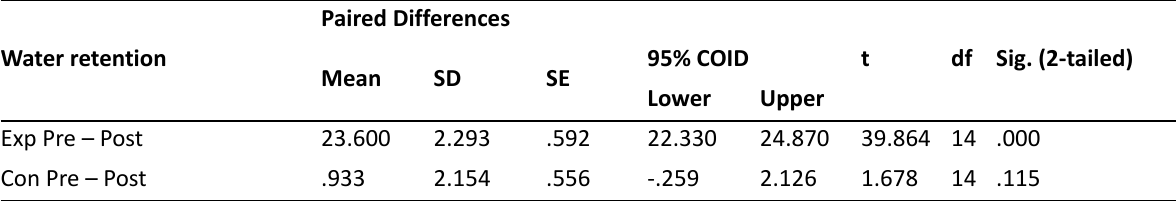
Table 6. Pre and post mean differences of experimental and control groups for negative reaction